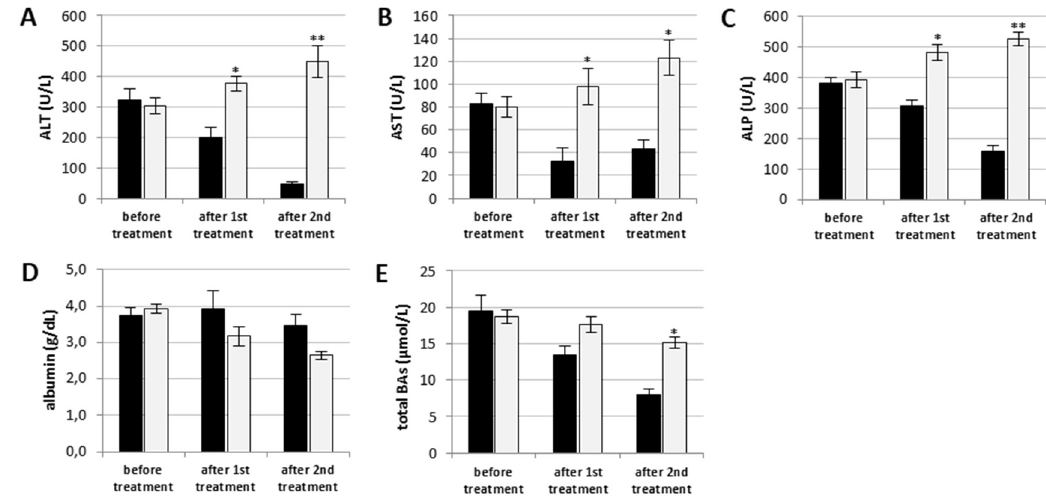
Figure 8. Serum levels of liver biomarkers. Serum levels of ( A ) ALT, ( B ) AST, ( C ) ALP, ( D ) albumin, and ( E ) total BAs were measured in blood samples collected before injection and seven days after each transplantation. Black bars represent the transplanted group; grey bars relate to the PBS-treated control group. In healthy dogs, the levels of ALT, AST, ALP, and total BAs should be less than 120 U/L, 50 U/L, 130 U/L, and 12.5 µ mol/L, respectively. For albumin, the normal range is between 2 and 4 g/dL. Data are expressed as mean ± standard deviation. * p < 0.05, ** p < 0.01 indicate statistically significant difference compared to levels recorded in the control group.